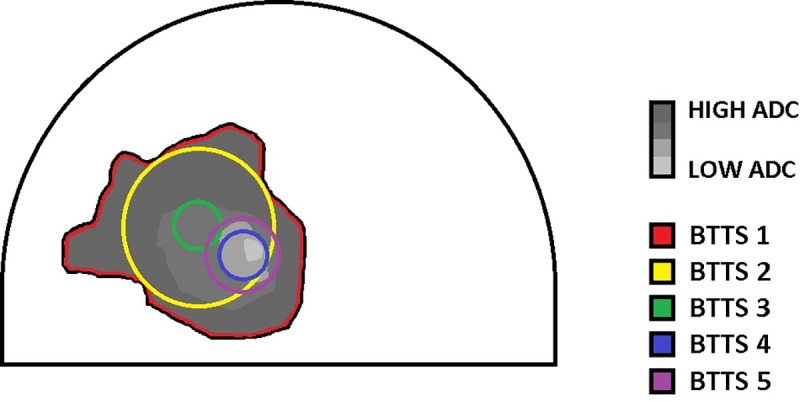
Schematic overview of the five breast tumor tissue selection methods in a breast lesion on diffusion weighted imaging.BTTS = Breast tumor tissue selection, ADC = Apparent diffusion coefficient.